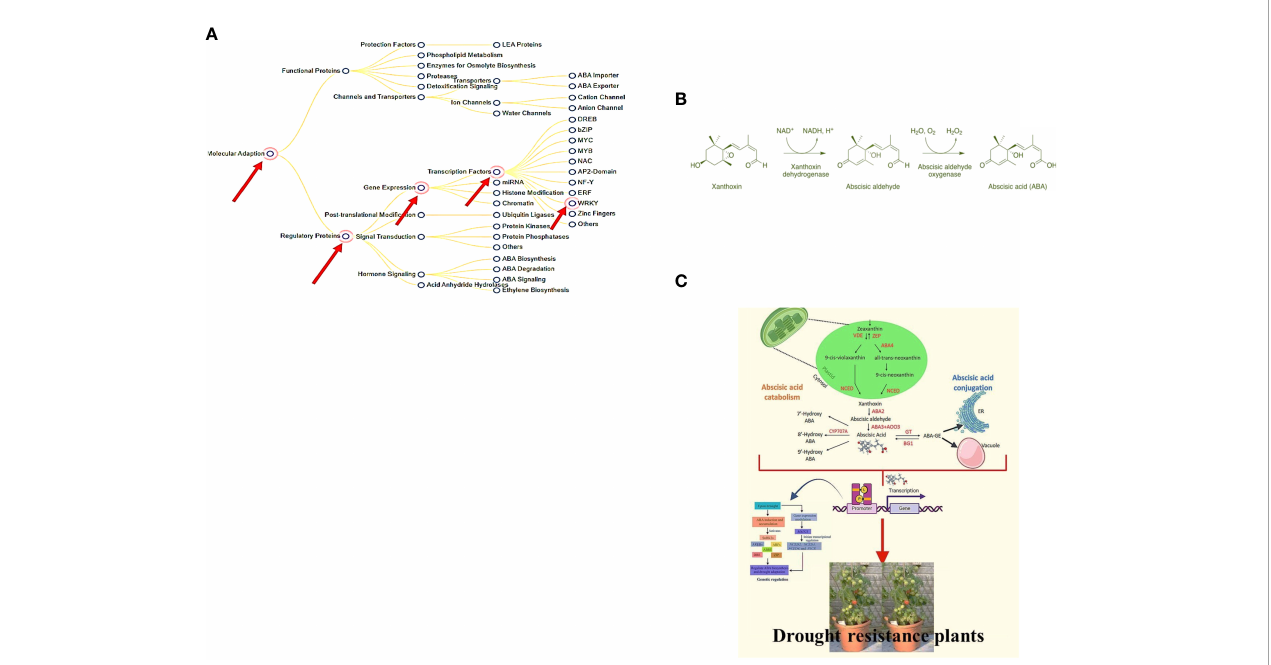
FIGURE 1 (A) Enhanced tolerance to drought & biotic stress and genes responsible ( Available from: https://pgsb.helmholtz-muenchen.de/droughtdb/drought_db.html). (B) Abscisic acid bio-synthesis. (C) Role of Abscisic acid in enhancing drought resistance and improved fruits production (Created with Adobe